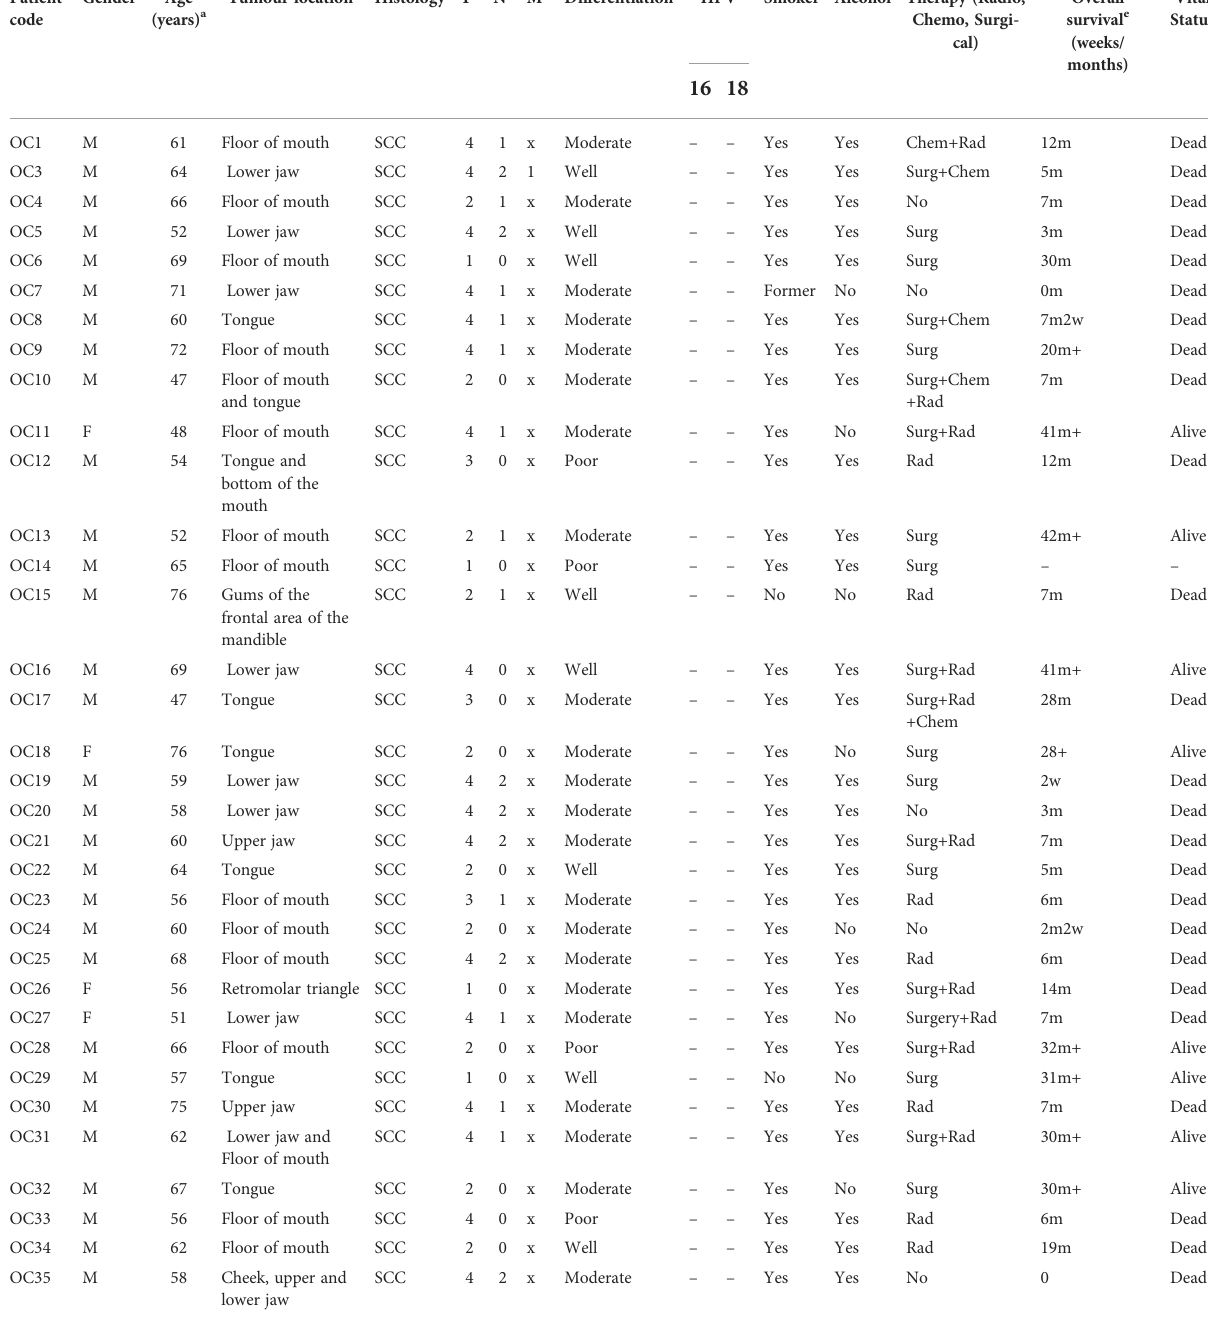
TABLE 1 Clinical and demographic characteristics of the UHSG patient